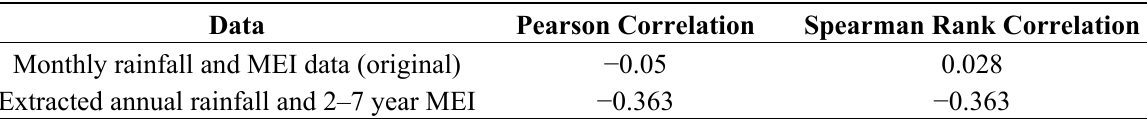
Table 4. Comparison of correlation results of unfiltered and filtered rainfall and multivariate El Niño-Southern oscillation index (MEI) data.